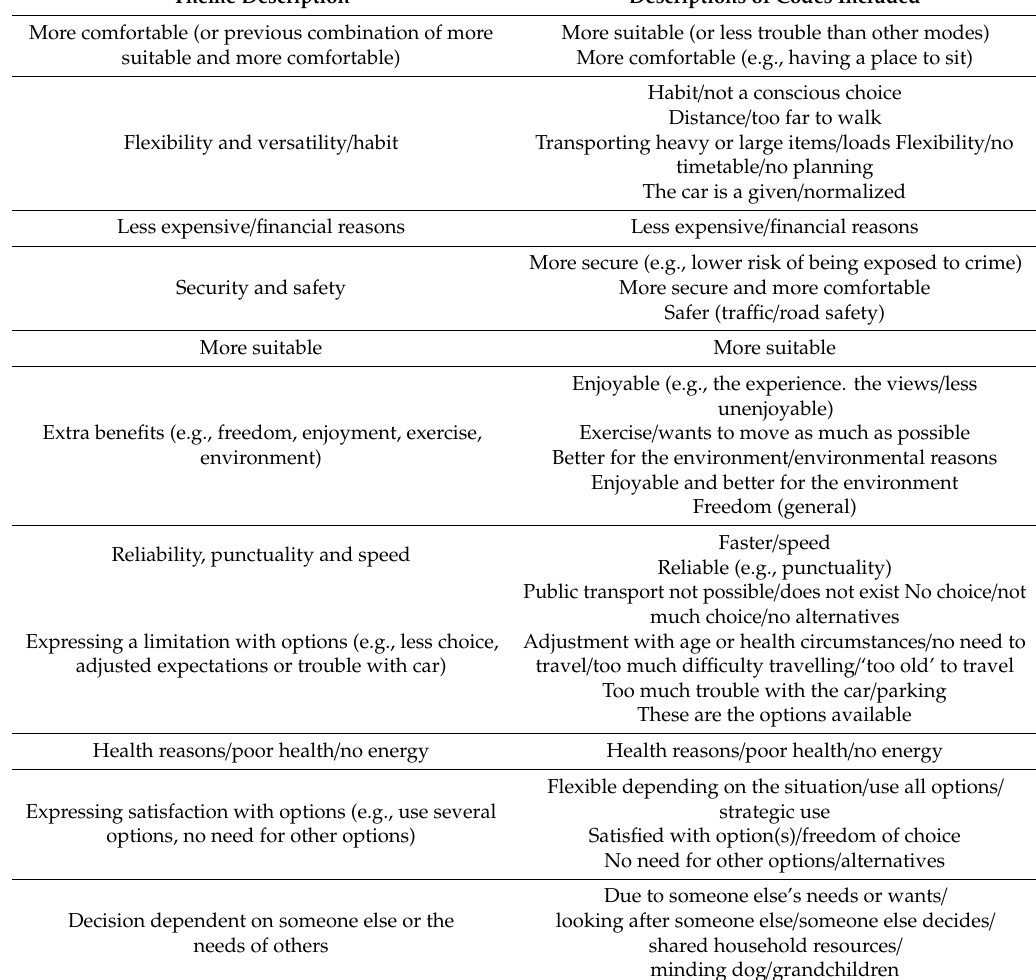
Table 4. Theme descriptions and the descriptions of codes included in each